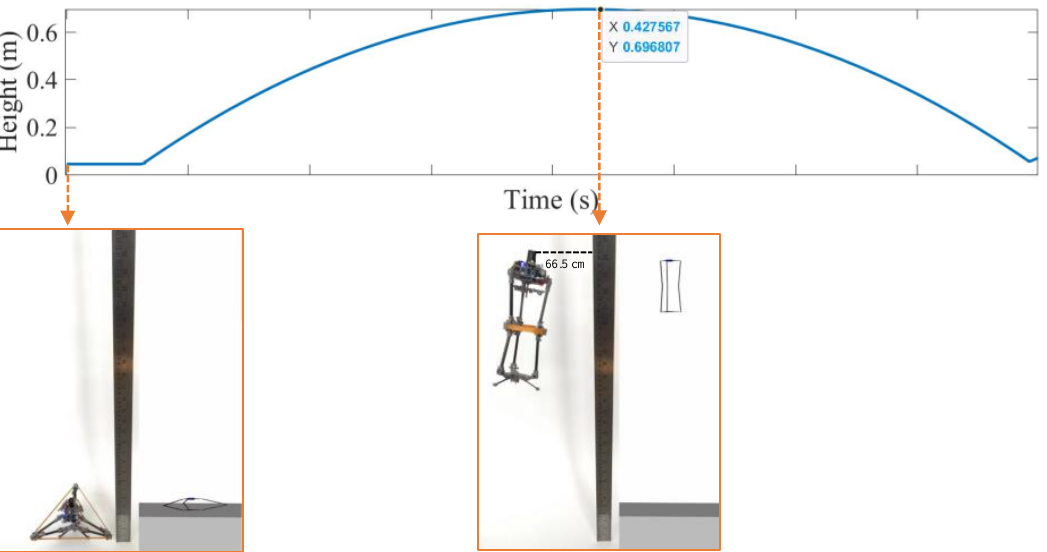
Figure 6. The height reached by the robot in the simulation and the corresponding two sets of comparison pictures.